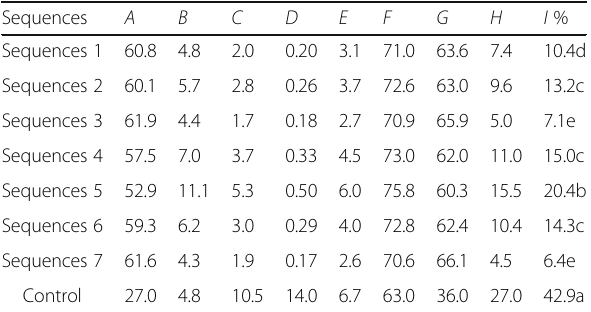
Table 8 Assessment of loss due to bollworms in different sequence treatments during season